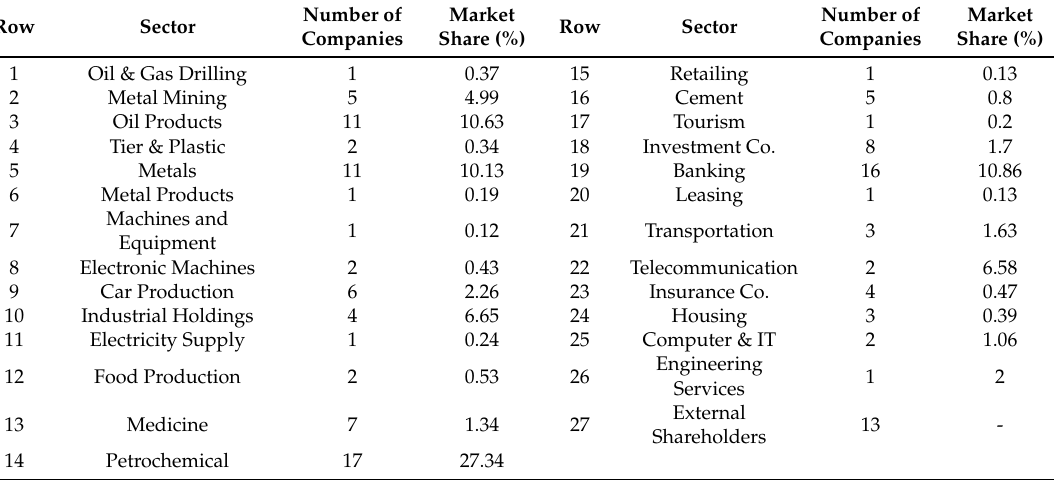
Table 1. General summary of the selected